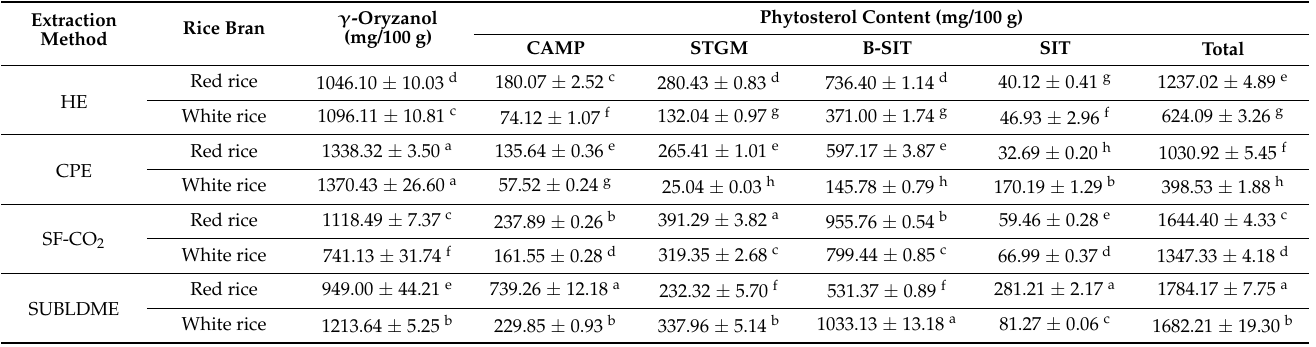
Table 5. γ -oryzanol and phytosterol contents (dry basis) of crude rice bran oil extracted using various extraction